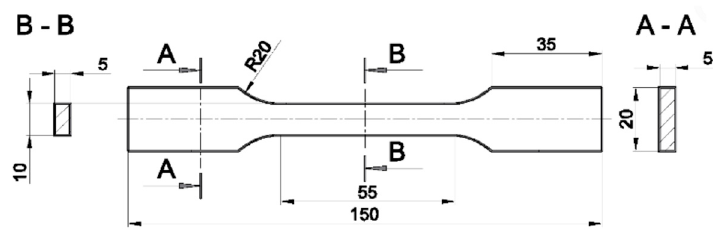
Figure 2. Geometrical characteristics of specimen, (mm).